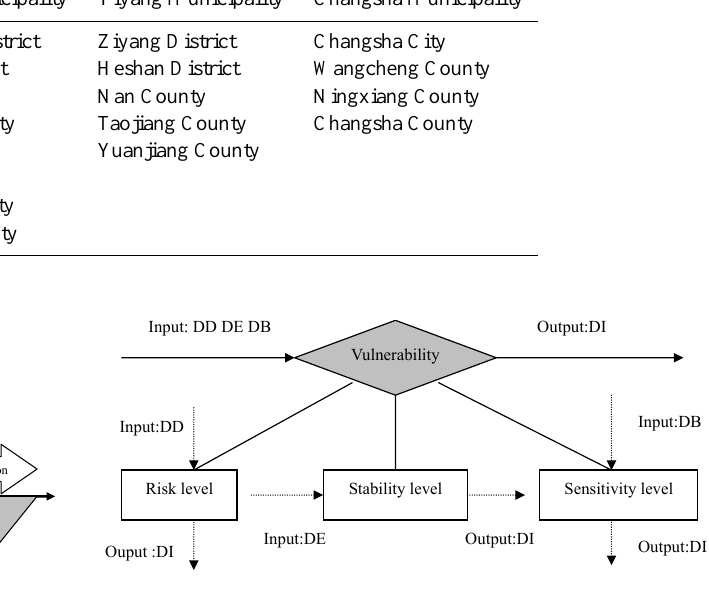
Fig.3 Flood disaster vulnerability and its decomposition Fig. 3. Flood disaster vulnerability and its